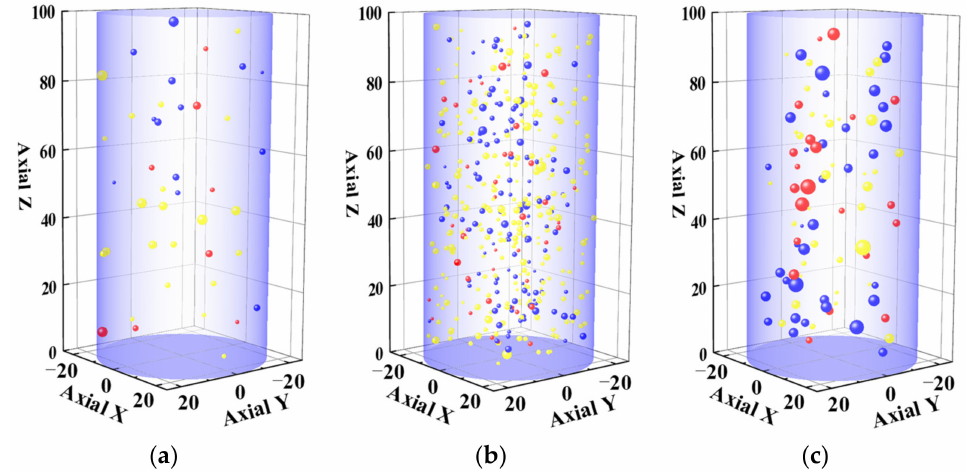
Figure 18. AE moment tensor inversion results for F2-1 at different fatigue crack growth stages. ( a ) Fatigue crack initial propagation stage; ( b ) fatigue crack stable propagation stage; ( c ) fatigue crack unstable propagation stage.